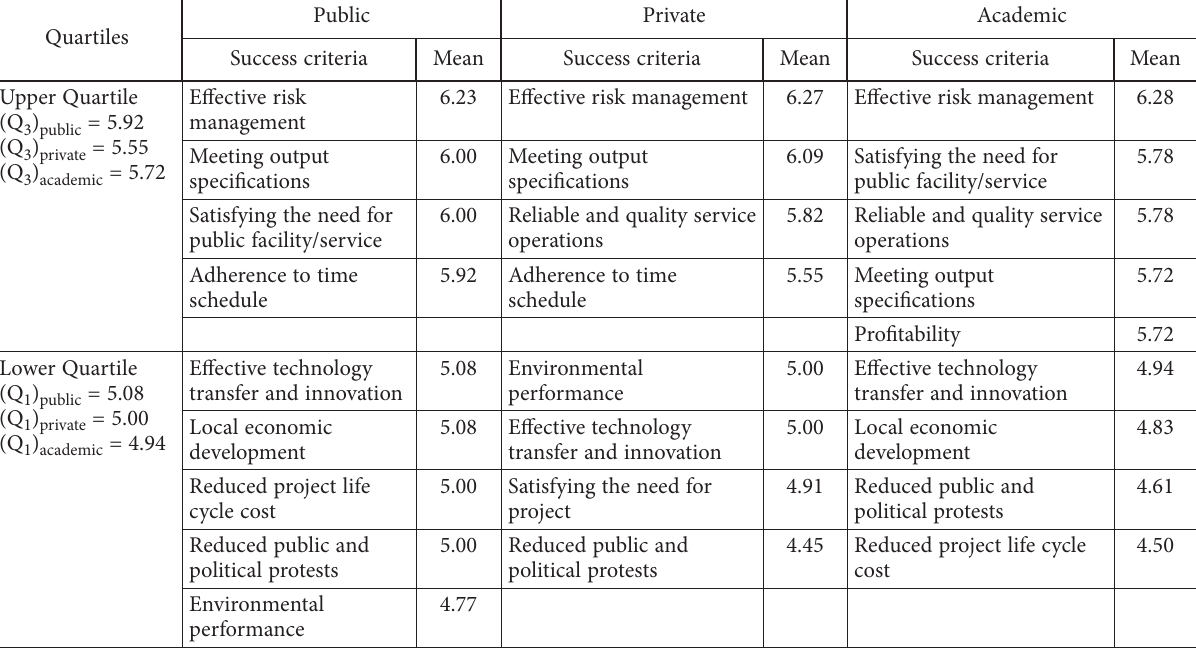
Table 6. Quartile groupings of PPP projects success criteria from stakeholders’ perspectives